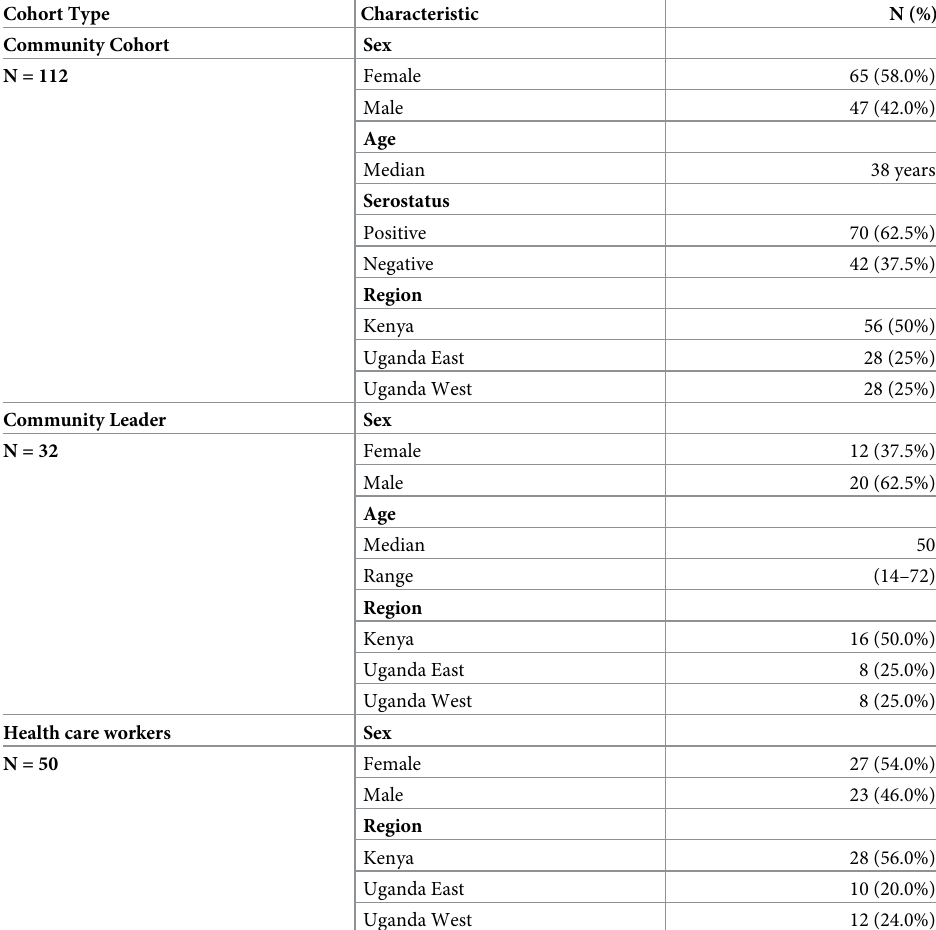
Table 1. Participant